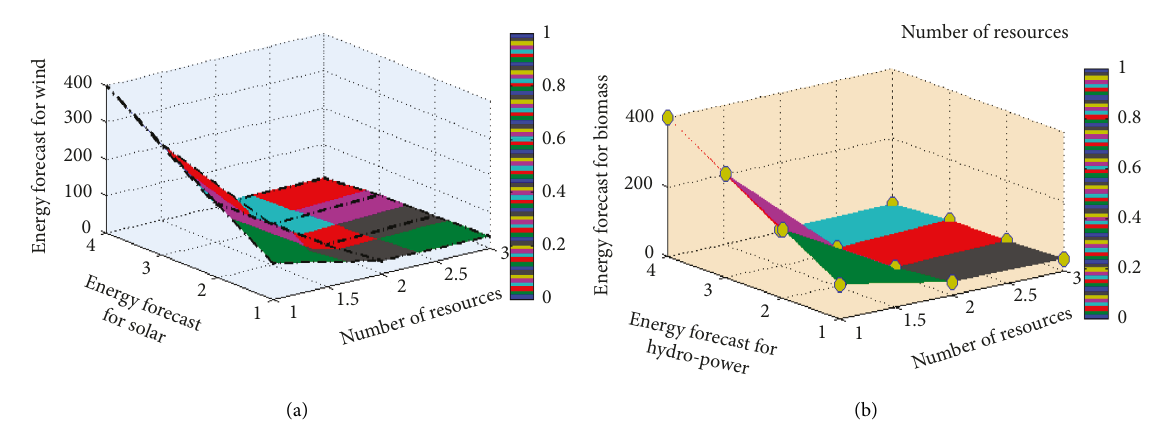
Figure 7: Accuracy of forecast. (a) Solar vs wind. (b) Hydro-power vs biomass.